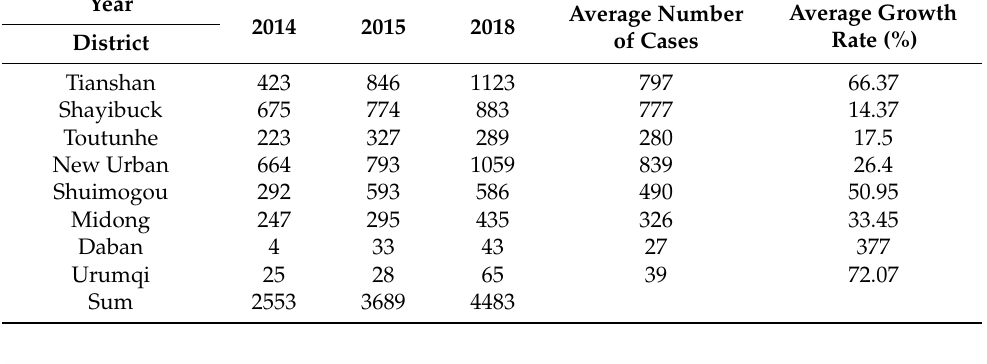
Table 3. Number of HFMD cases in Urumqi from 2014 to 2018.